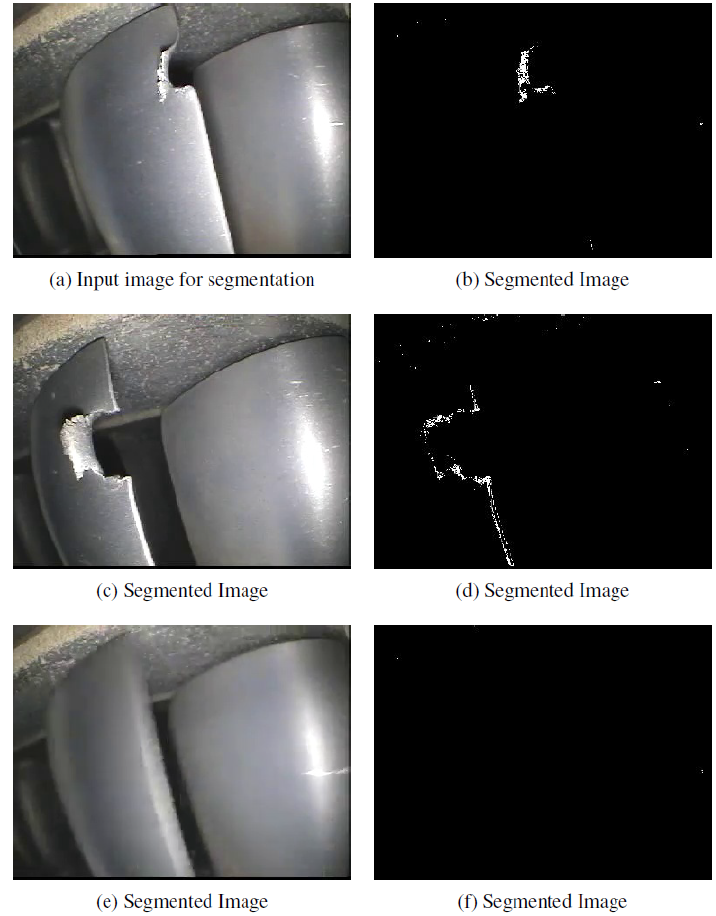
Figure 14. Image segmentation using Random